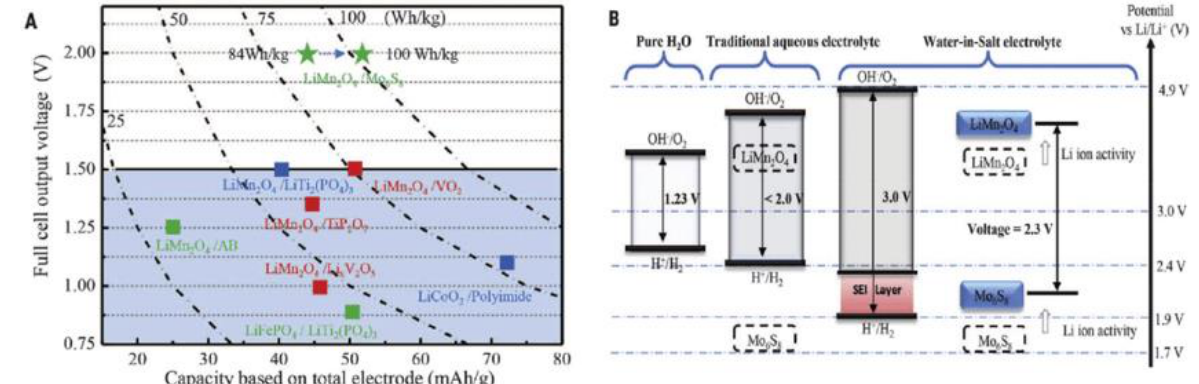
Figure 8. ( A ) Performance of each aqueous LIB based on different redox couples. Cycling stability: red color, 1000 cycles. ( B ) Representation of enlarged potential window for WiSEs together with the modulated redox couples of LiMn 2 O 4 cathode and Mo 6 S 8 anode due to high content of salt